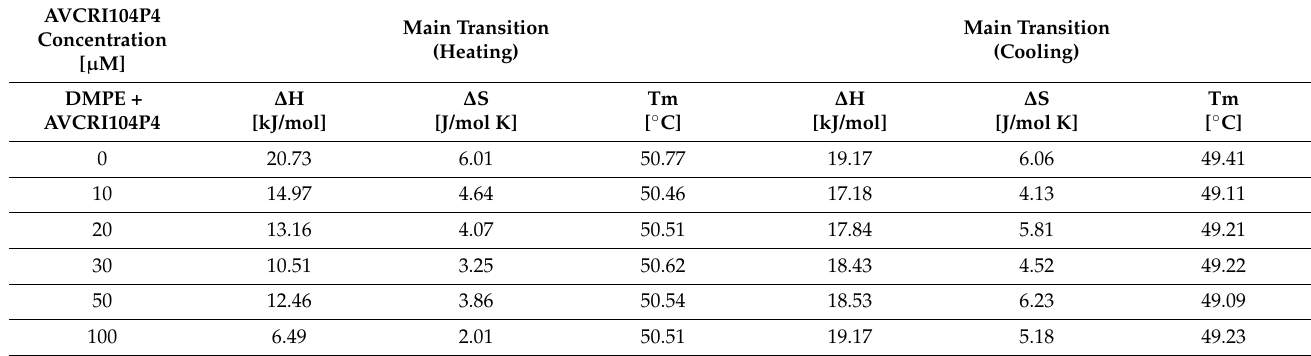
Figure 6. ( A ) Representative DSC curves obtained for multilamellar DMPE liposomes containing different AVCRI104P4 concentrations. Scans were recorded at a heating rate of 1 ◦ C min − 1 ; ( B ) a plot of phase transition temperature of DMPE multilamellar liposomes determined for cooling and heating scans as a function of AVCRI104P4 concentration. Table 5. Thermodynamic parameters of pre-transition and main phase transition of pure, fully hydrated, multilamellar liposomes and mixtures of DMPE/AVCRI104P4 obtained from heating and cooling scans collected at a rate of 1 ◦ C min − 1 for both processes. The accuracy of the main phase transition temperature and enthalpy was ± 0.01 ◦ C and ± 0.8 kJ/mol, respectively. AVCRI104P4 Main Transition Main Transition Concentration (Heating) (Cooling) [ µ M] DMPE +